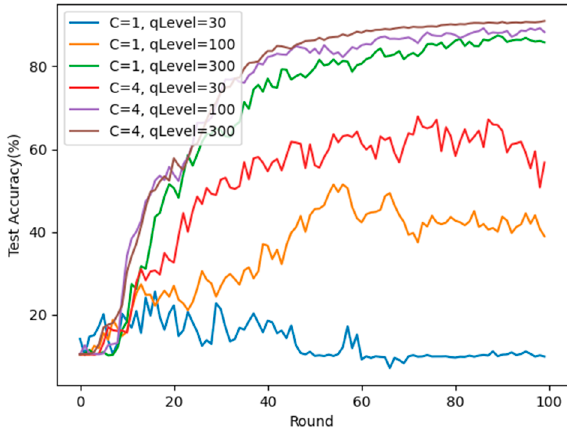
Figure 4. Accuracy according to the quantization levels.